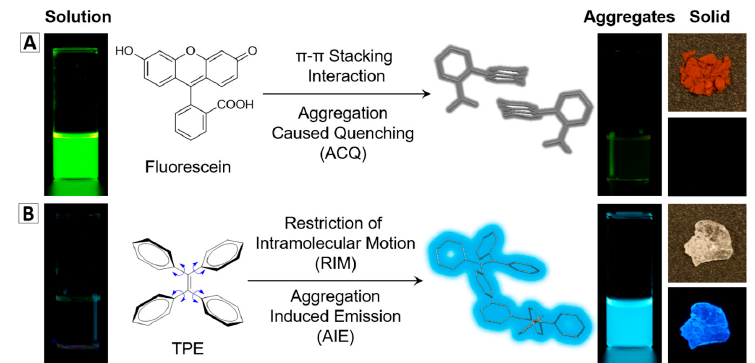
Figure 1. Typical example of ( A ) conventional fluorescent agents: fluorescein is a strong emitter in the solution state, but is quenched in the aggregate state or solid state; ( B ) AIEgens: tetraphenylethene (TPE) turns on its emission upon aggregate formation [2] (reproduced from [2] with permission (2016) of the Royal Society of Chemistry).